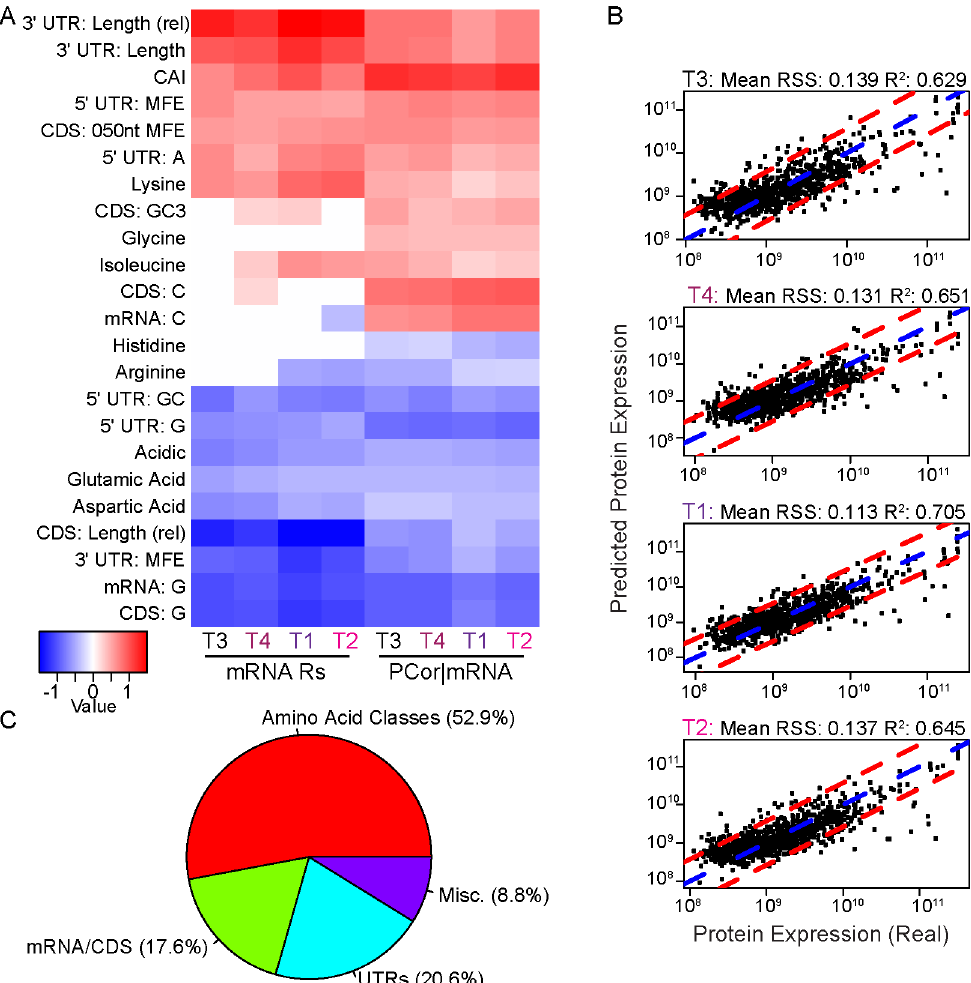
Fig 5. Testing the effectiveness of sequence features as proxies for post-transcriptional control. (A) Partial correlation matrix of the most correlated and anti-correlated features that were significantly partially correlated with protein expression in all time points, as indicated by bootstrap testing. The left four columns indicate the Spearman correlation between mRNA expression and the features per time point; the right four columns show the partial correlation of the features with the protein expression, when accounting for their correlation with the mRNA expression. As expected, features such as CDS sequence length were anti-correlated with mRNA and protein expression. An anti-correlation observed with the minimum free energy (MFE) in 3 ’ UTRs was notable, indicating that greater 3 ’ UTR structure is correlated with protein expression. (B) Comparison of the real versus predicted protein abundances for each sample. The blue dotted line indicates the slope and intercept for a perfect correlation (y = x); while the red dotted lines indicate the 5% and 95% quartiles for the residuals from the predicted protein expression abundances. (C) Categories of sequence features used in two or more of the MARS models. While features from the CDS, mRNA and UTR sequences comprised roughly 38% of the selected features, the majority were proportions of amino acid and amino acid classes in the protein